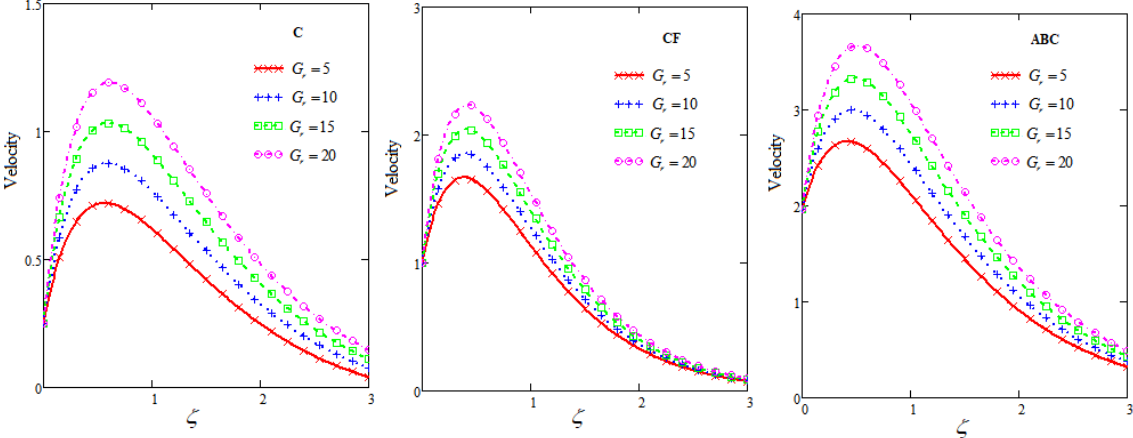
Figure 5. Velocity curves corresponding to C, CF and ABC with variable G r where P r = 7, S c = 0.66, κ = 0.5, G m = 5, H = 3, R = 5, S r = 3, K r = 2, M = 0.5, γ 1 = 0.1, h = 0.5, c = 1.05 and b =